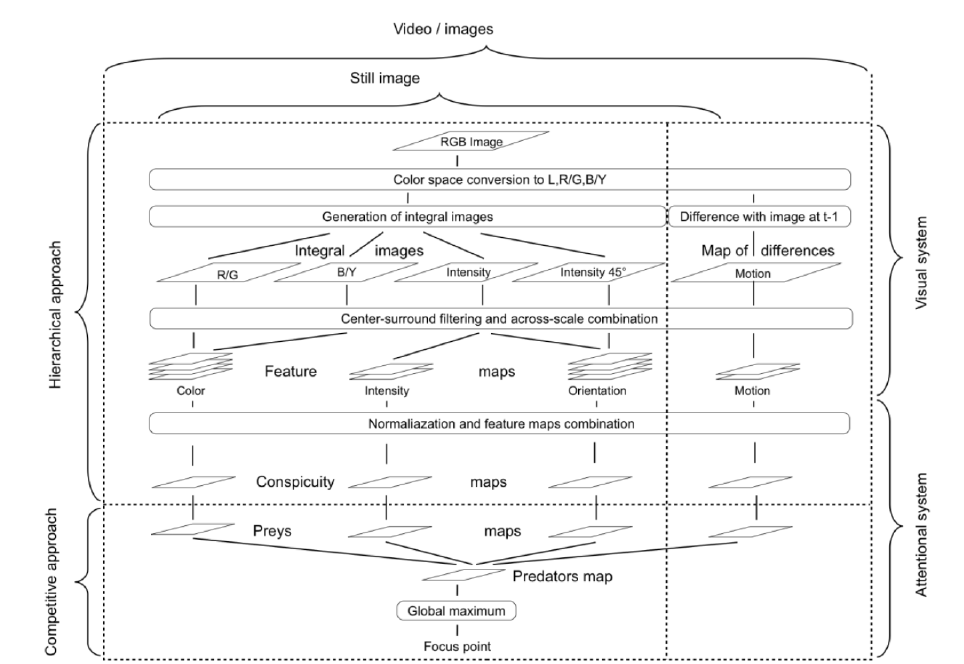
Figure 6. Architecture of the Perreira computational model of